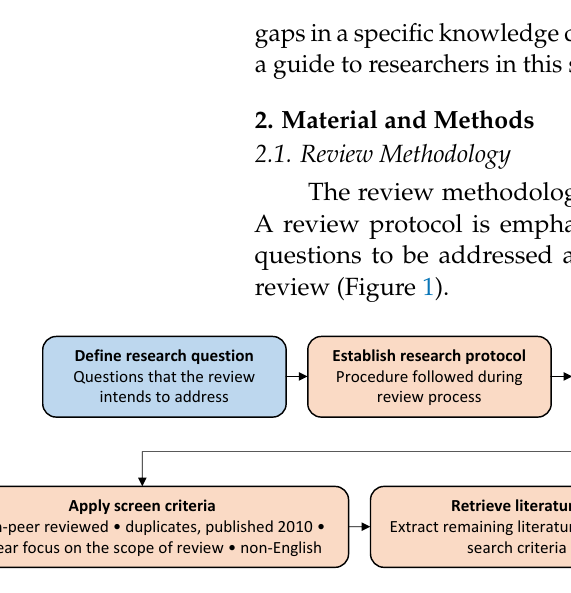
Figure 1. Flowchart for conducting systematic literature review showing planning, conducting, and reporting